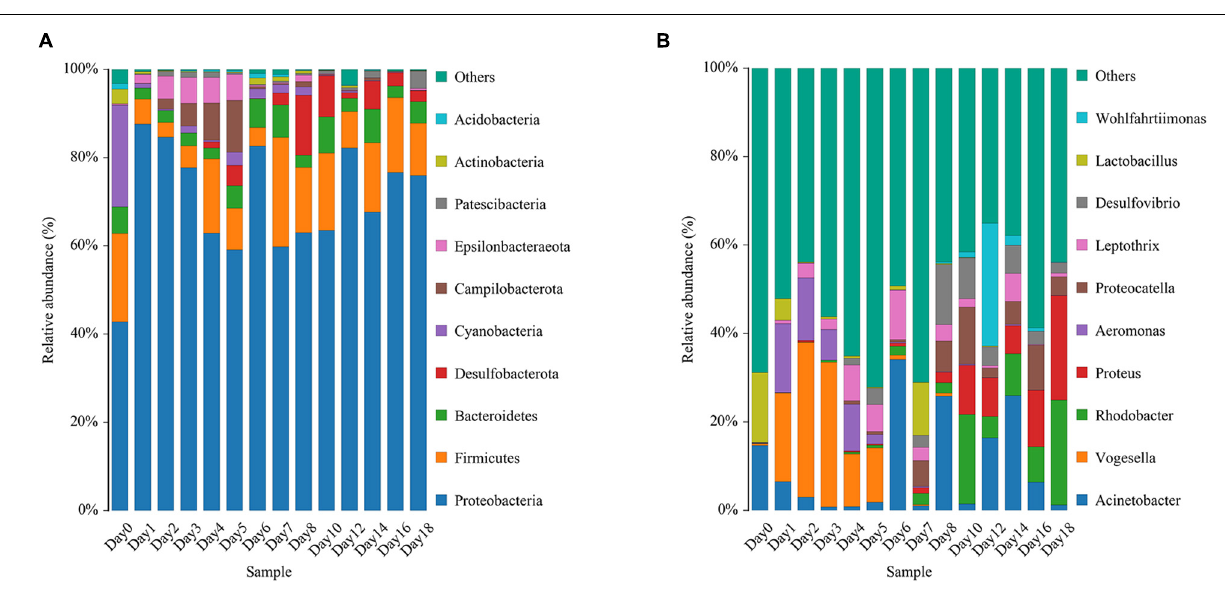
FIGURE 4 | Variation in the bacterial community structure on the skin surface during decomposition at the phylum level (A) and genus level (B) (only the top 10 most